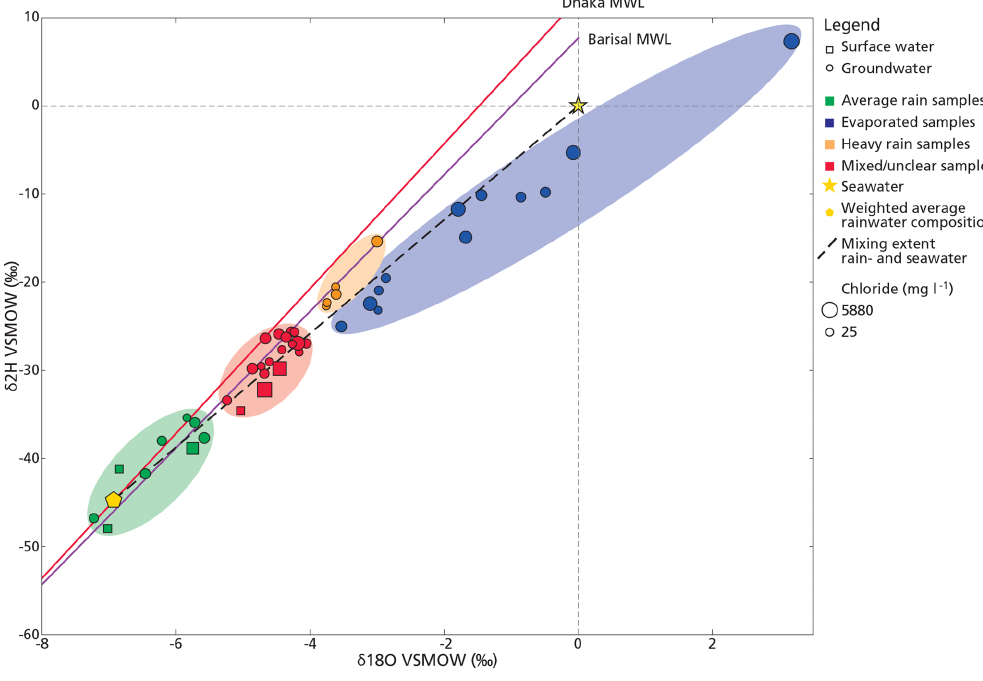
Figure 4. Stable isotope content in the study area. Local meteoric water lines based on monthly samples from the two closest stations Dhaka and Barisal at respectively 185 and 125km from the study area (IAEA/WMO, 2017). The mixing line between rainwater and seawater is based on the weighted average rainwater composition from Barisal (IAEA/WMO, 2017) and seawater